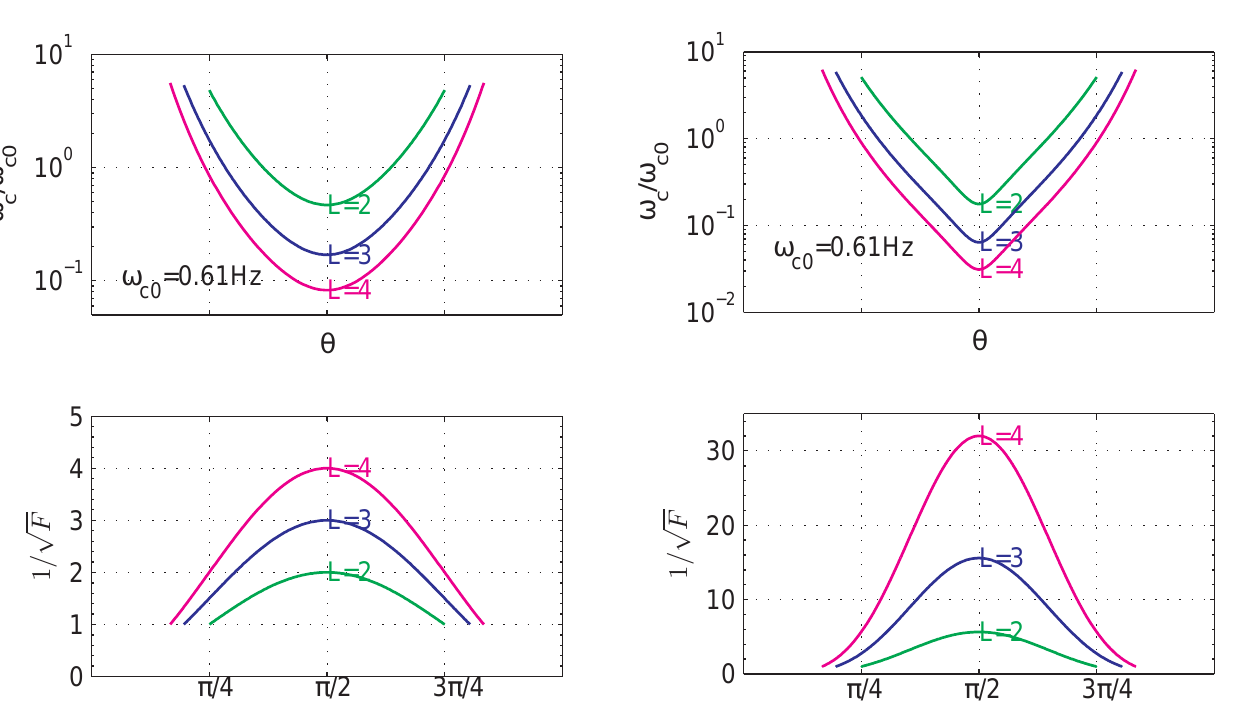
Fig. 1. The parameter ω c normalized by ω c 0 (with B 0 = 0 . 31 Gauss, a = 6 . 4 × 10 8 cm, and n e = 6 . 0 × 10 4 cm − 3 ), and the adiabatic growth/decay factor as a function of θ for various L values ( p = 3 ).